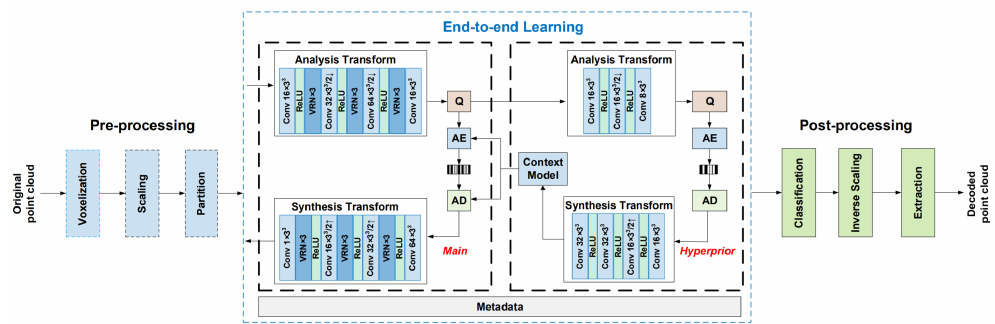
Figure 17. Architecture proposed in